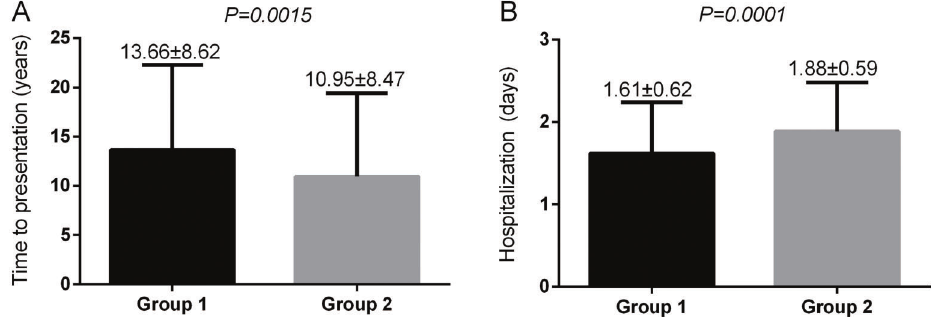
Figure 2. A , Time from onset of symptoms to presentation in patients with truncal versus (Group 1) and diffuse varicose veins (Group 2). B , Number of hospitalization days of patients according to groups. Data are reported as means ± SD. Fisher ’ s exact test was used for statistical